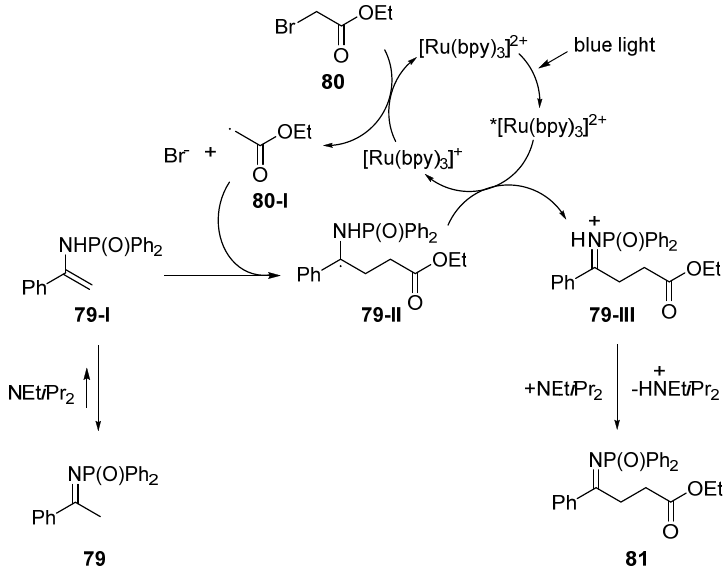
Table 1. Various catalytic systems for the α -alkylation of carbonyl